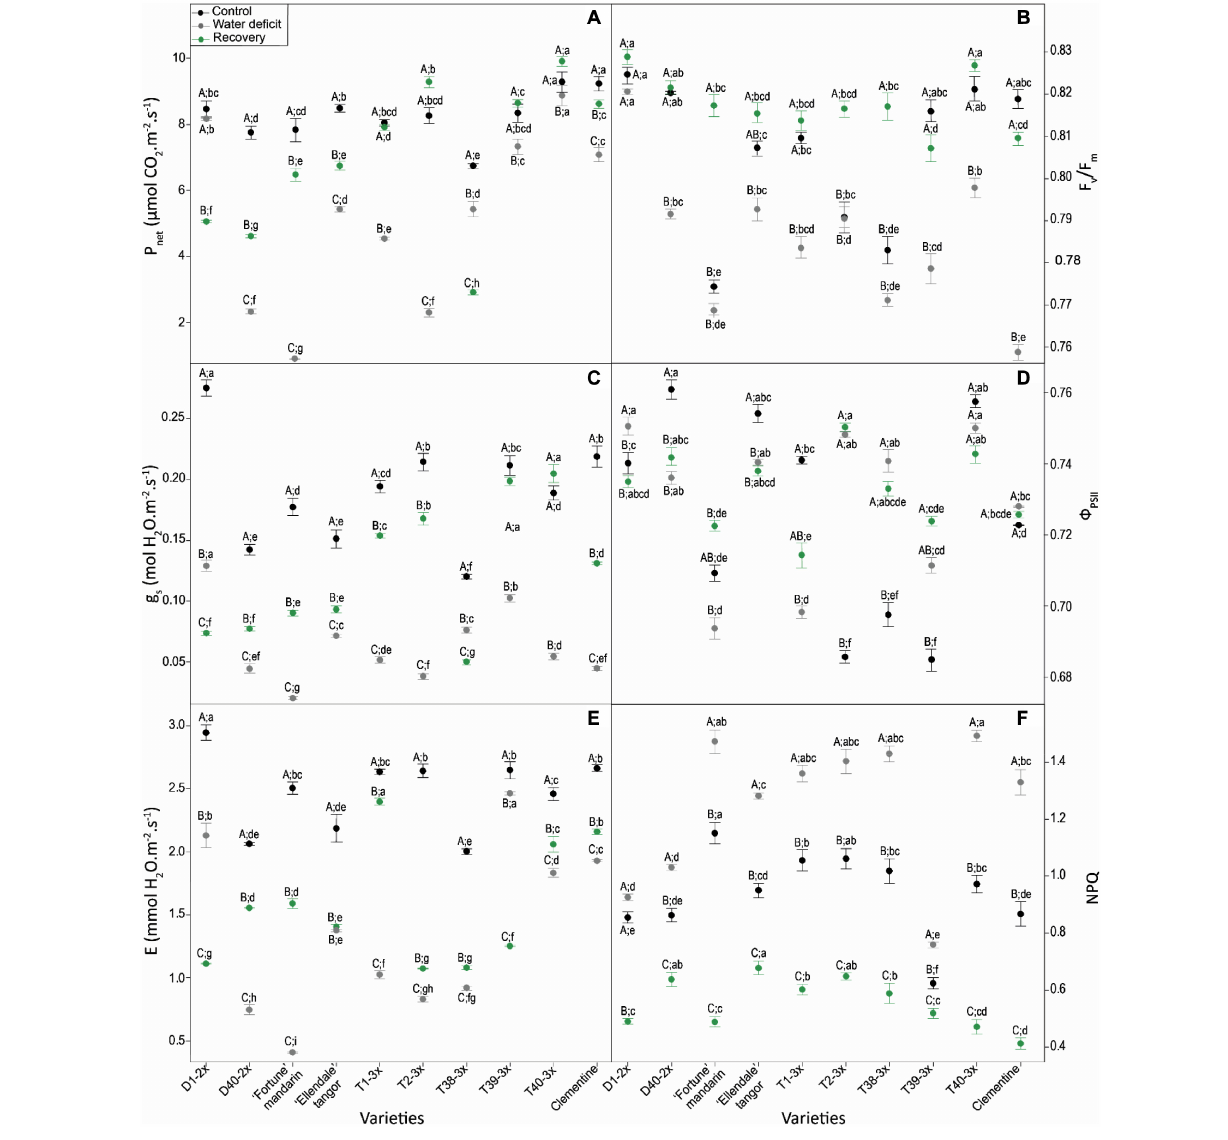
FIGURE 3 | Changes in (A) net photosynthesis ( Pnet ), (B) maximal quantum yield of PSII ( F v / F m ), (C) stomatal conductance ( gs ), (D) actual quantum yield of PSII ( (cid:56) PSII ), (E) transpiration, and (F) non photochemical quenching (NPQ) in citrus varieties under three different water conditions: control (black points), water deficit (gray points) and after re-watering (recovery; green points). All data are mean values ( ± S.E.) of 15 independent measurements ( n = 15). Data were analyzed using ANOVA and Fisher LSD test ( P < 0.05). Different capital letters indicate significant changes between the conditions (control, water deficit, recovery) for each variety while different lower case letters indicate changes between the varieties for each